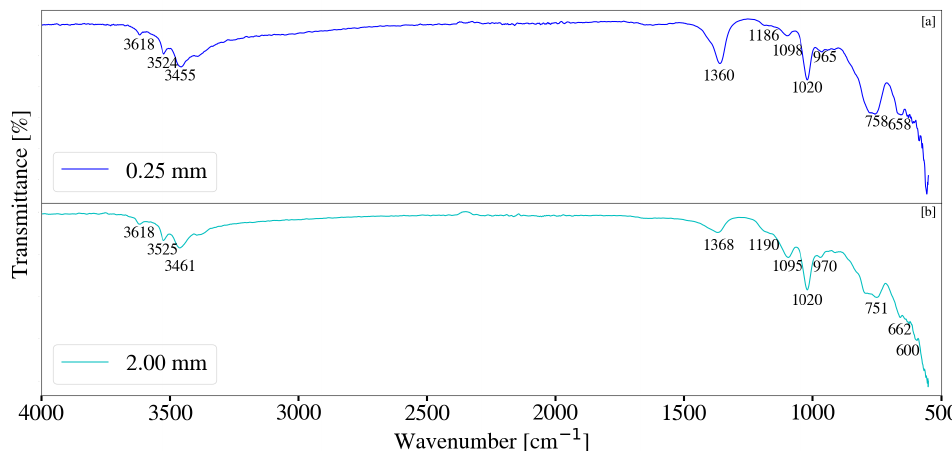
Figure 19. ( a ) FT-IR analysis for Mg-Al LDH sample synthesised using milling media size of 2 mm (S2). ( b ) FT-IR-analysis for Mg-Al LDH sample synthesised using milling media size of 0.25 mm